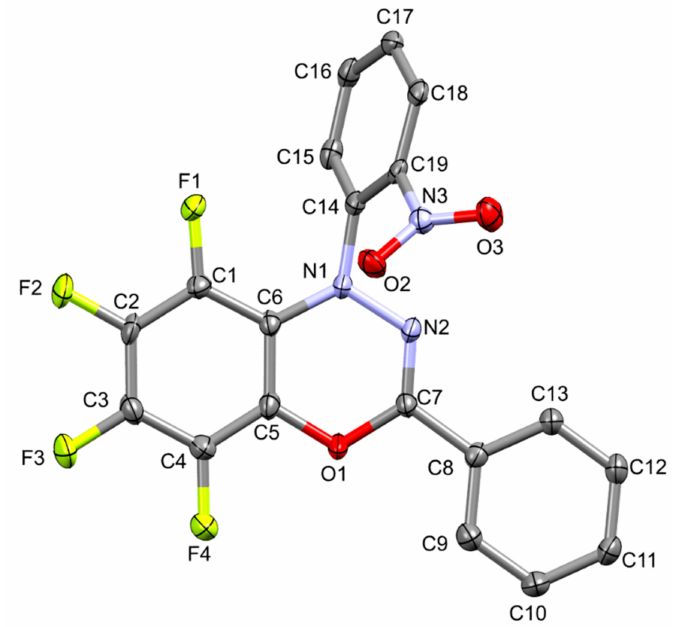
Figure 1. ORTEP view of 5,6,7,8-tetrafluoro-1-(2-nitrophenyl)-3-phenyl-1 H -benzo[ e ][1,3,4]oxadiazine ( 5 ) (CCDC-1842283). 50% Probability ellipsoids. Hydrogens omitted for clarity. Crystallographic numbering